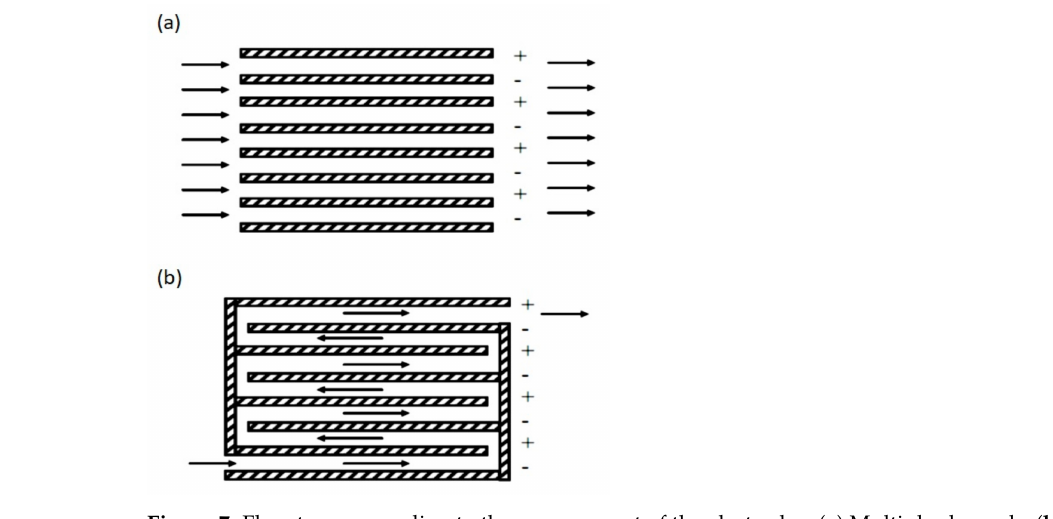
Figure 7. Flow types according to the arrangement of the electrodes: ( a ) Multiple channels; ( b ) single channel